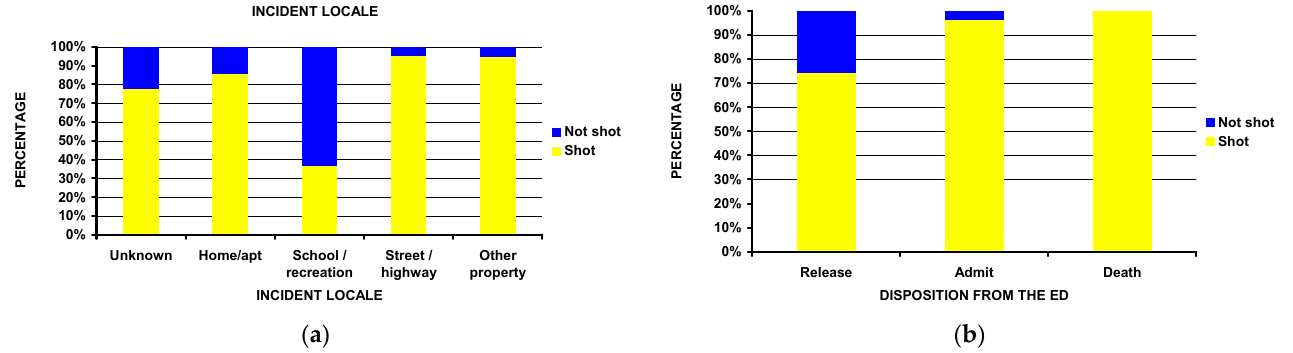
Figure 4. Differences between being shot or not. ( a ) By incident locale ( p < 10 − 4 ); ( b ) by disposition from the ED ( p < 10 − 4 ).